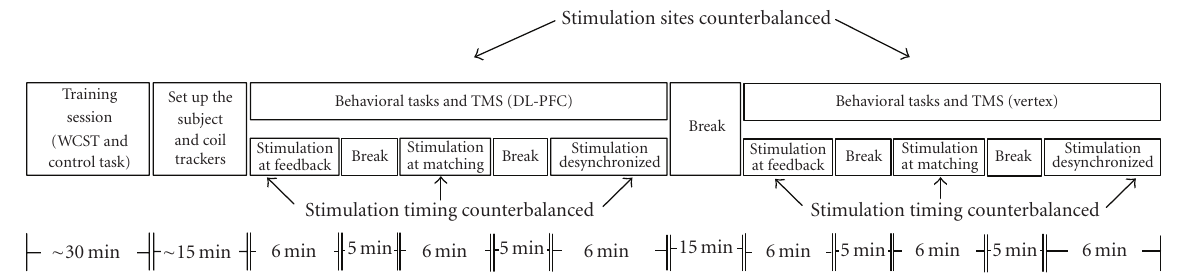
Figure 2: Timeline of the experimental setup. All subjects were trained for approximately 30 minutes at the beginning of the experiment. After registering the subjects’ anatomical land marks to their structural MRIs, the subjects performed 6 minutes of the behavioral tasks while rTMS was administered at DL-PFC or vertex (control) in three di ff erent timing conditions. The orders of stimulation sites and timings were counterbalanced. The behavioral tasks consisted of WCST and control task.